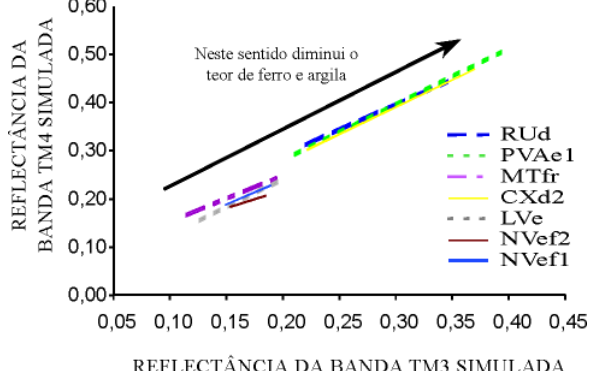
Figura 3. Linha do solo de amostras da camada subsuperficial, para algumas das classes de solos da área de estudo e o seu deslocamento em relação aos teores de ferro e argila nas amostras